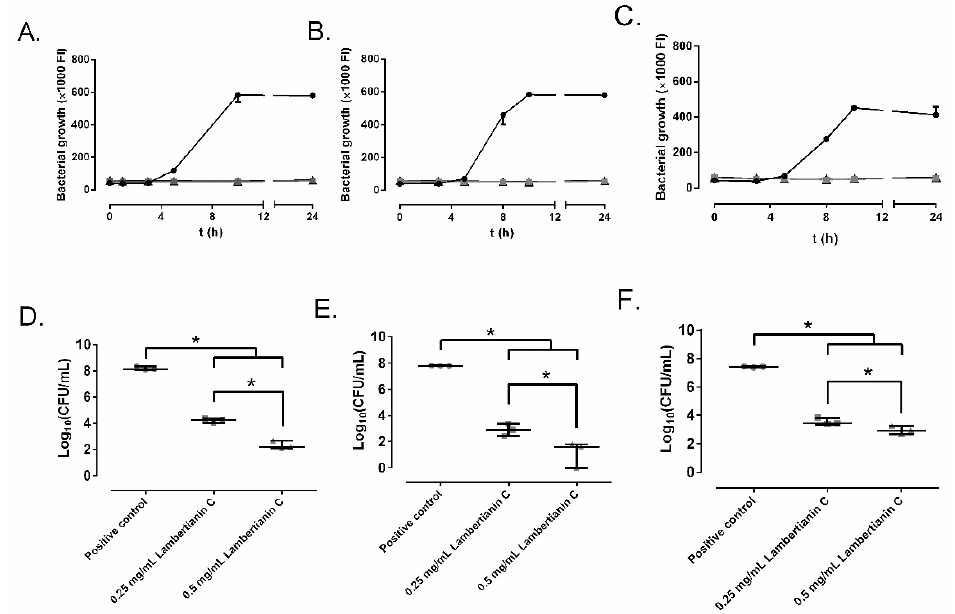
Figure 4. The effect of different concentrations of lambertianin C on SAP231 ( A , D ), MRSA 1 ( B , E ), and MRSA 2 ( C , F ) growth: control (circle), 0.25 mg/mL (square), and 0.5 mg/mL (triangle) over time ( A – C ) and at 24 h ( D – F ). *: p- value < 0.05 for Wilcoxon test.